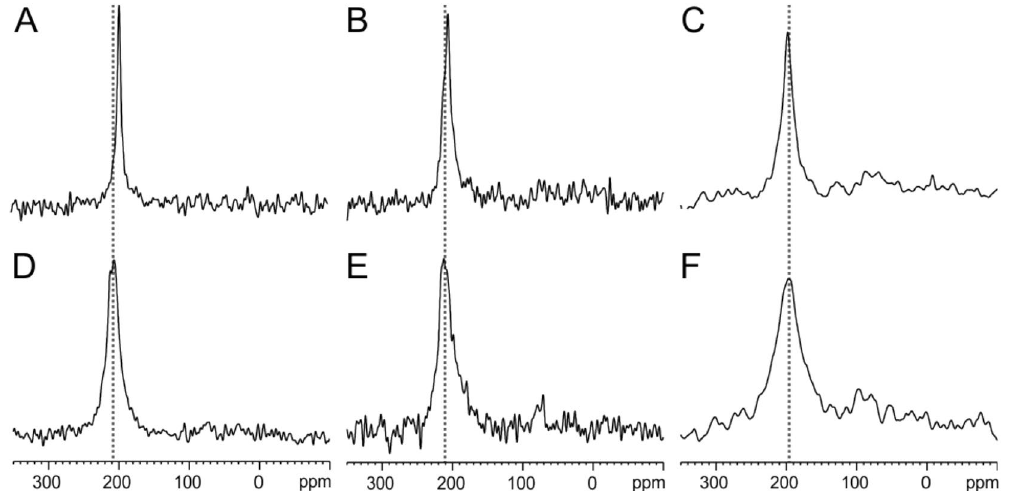
Figure 4. Proton-decoupled 15 N solid-state NMR spectra of [ 15 N-Leu8]-CRAC-TM_model ( A , D ) [ 15 N-Leu8]- CRAC-TM_model-scr with a scrambled amino acid arrangement of the CRAC region ( B , E ) and of [ 15 N-Leu8]- CRAC-TM_gp41 ( C , F ). The polypeptides were reconstituted into uniaxially aligned POPC lipid bilayers without ( A – C ) and with 30 mol% cholesterol ( D – F ) at a peptide-to-lipid ratio of 2 mol%. The membrane normal was parallel to the magnetic field of the NMR spectrometer and the experiments were performed at room